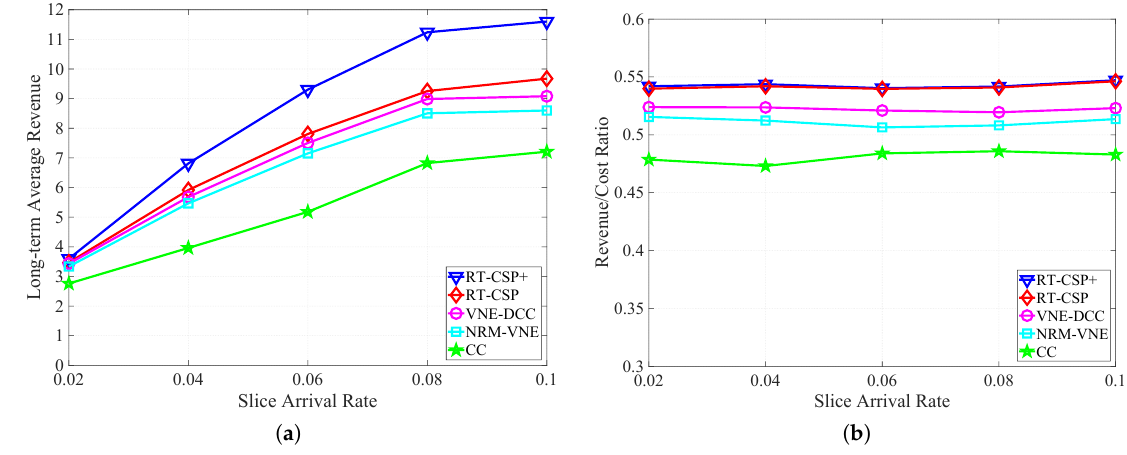
Figure 7. ( a ) Long-term average slice provisioning revenue in the different arrival rates scenario; and ( b ) slice provisioning revenue-to-cost ratio in the different arrival rates